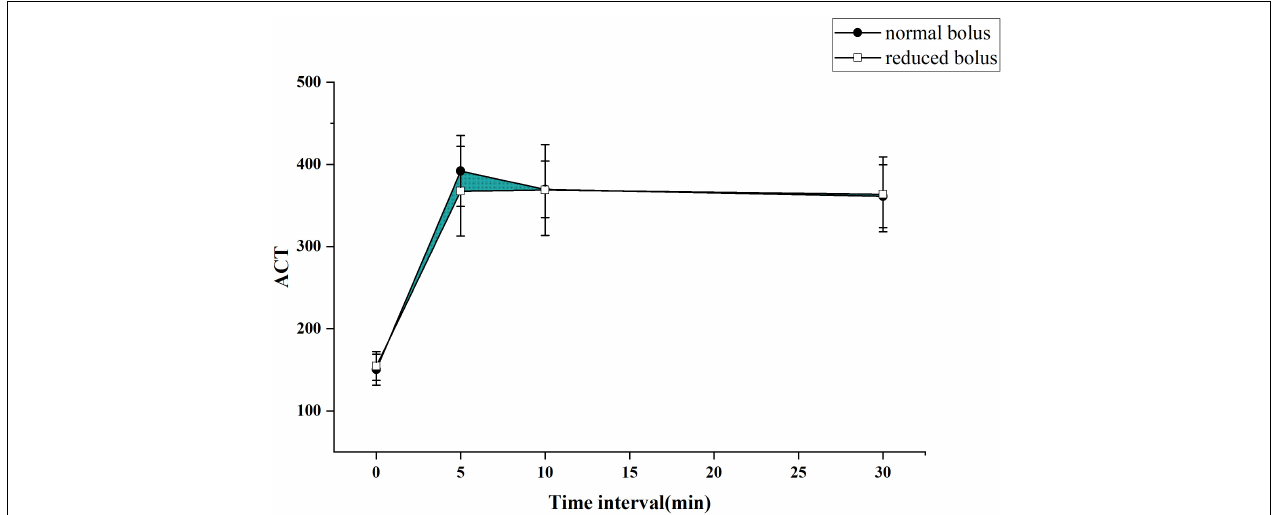
FIGURE 3 | The ACT curve in each group for patients with abnormal